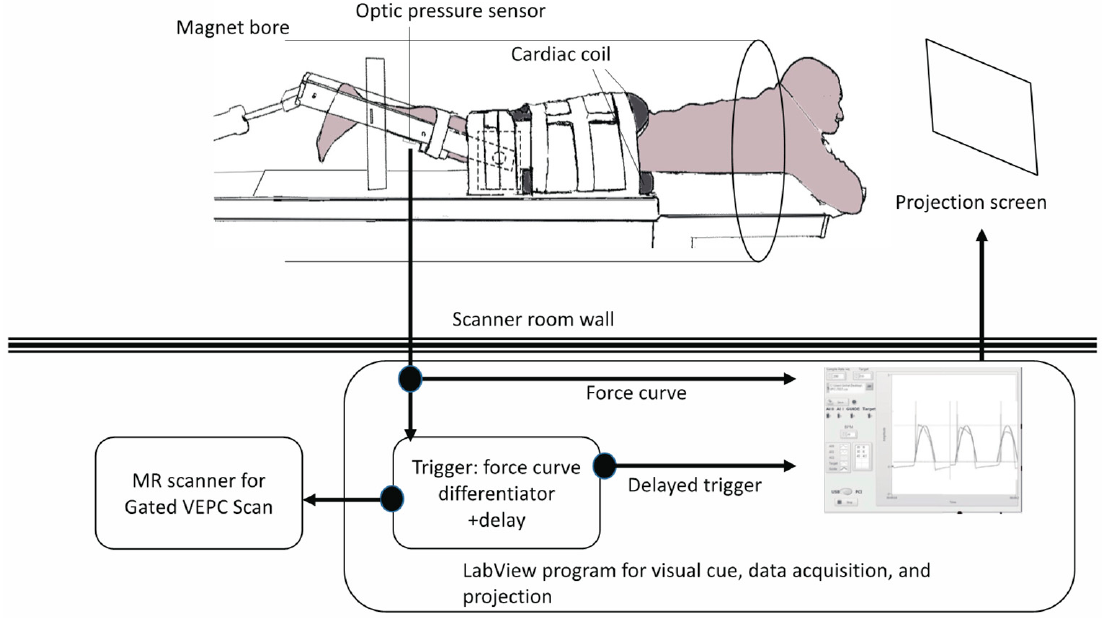
Figure 2. Illustration of the experimental setup of velocity-encoded phase contrast (VEPC) image